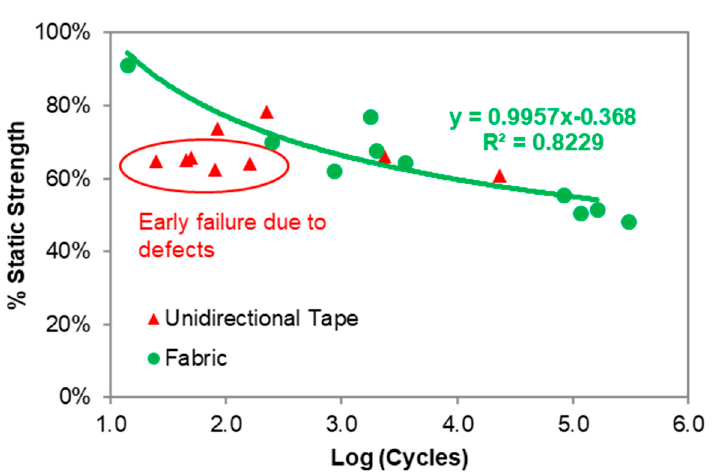
Figure 17. Unidirectional tape and fabric ILT fatigue; R = 0.1, 4 Hz.